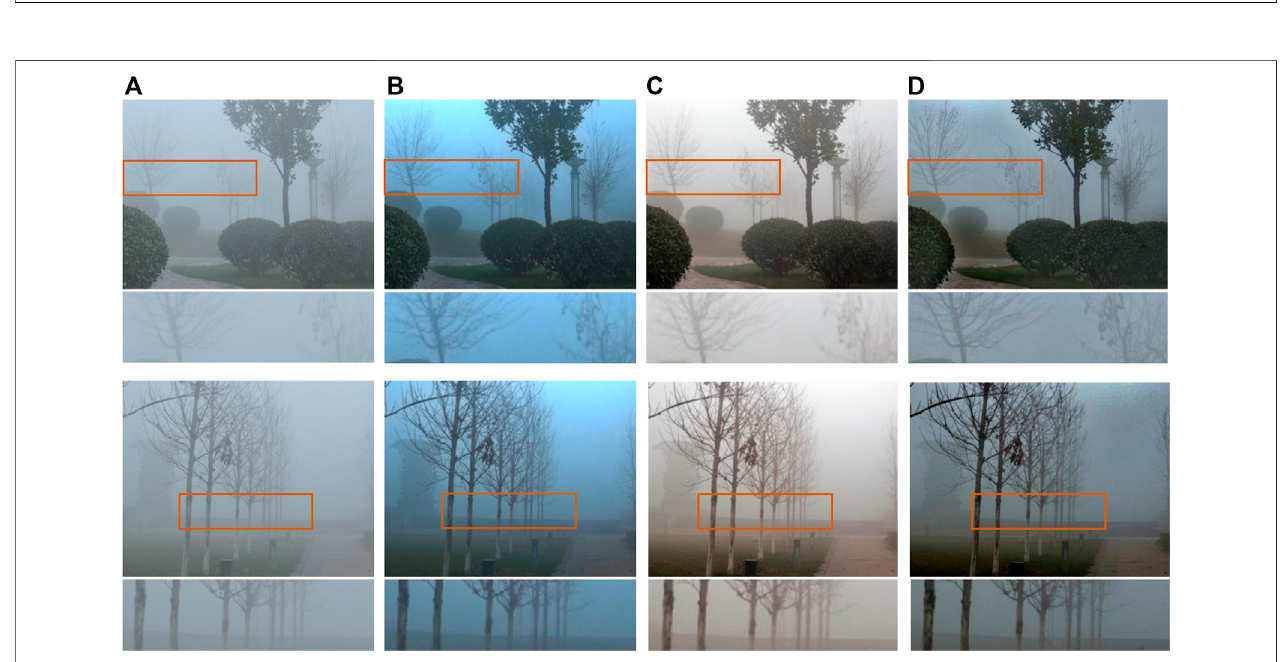
FIGURE 3 | The performance of different methods in the open-source dataset. (A) Original haze image. (B – D) Result of the DCP method, IIDWP method, and the proposed method respectively.